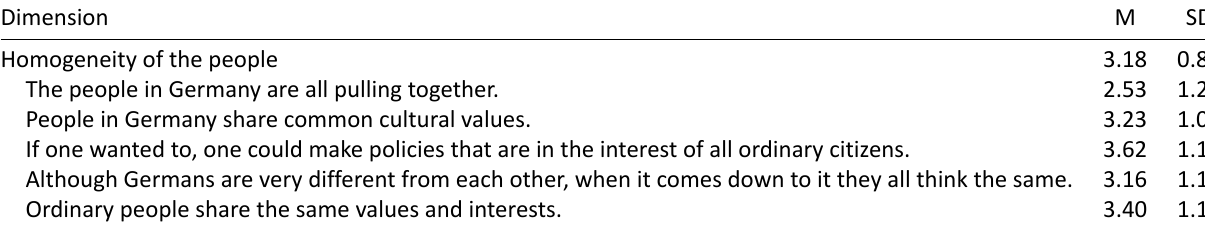
Table 1. Descriptive overview of populist attitude dimensions.